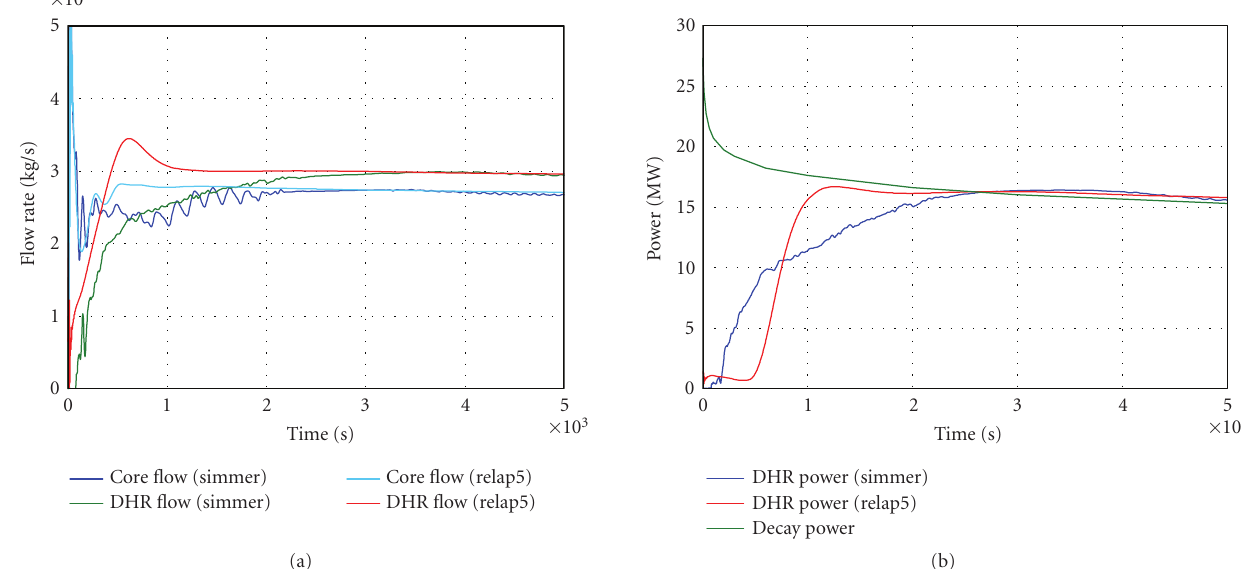
Figure 6: Lead mass flow rates (core and DHR) and heat removal in the DHR system (3 units).